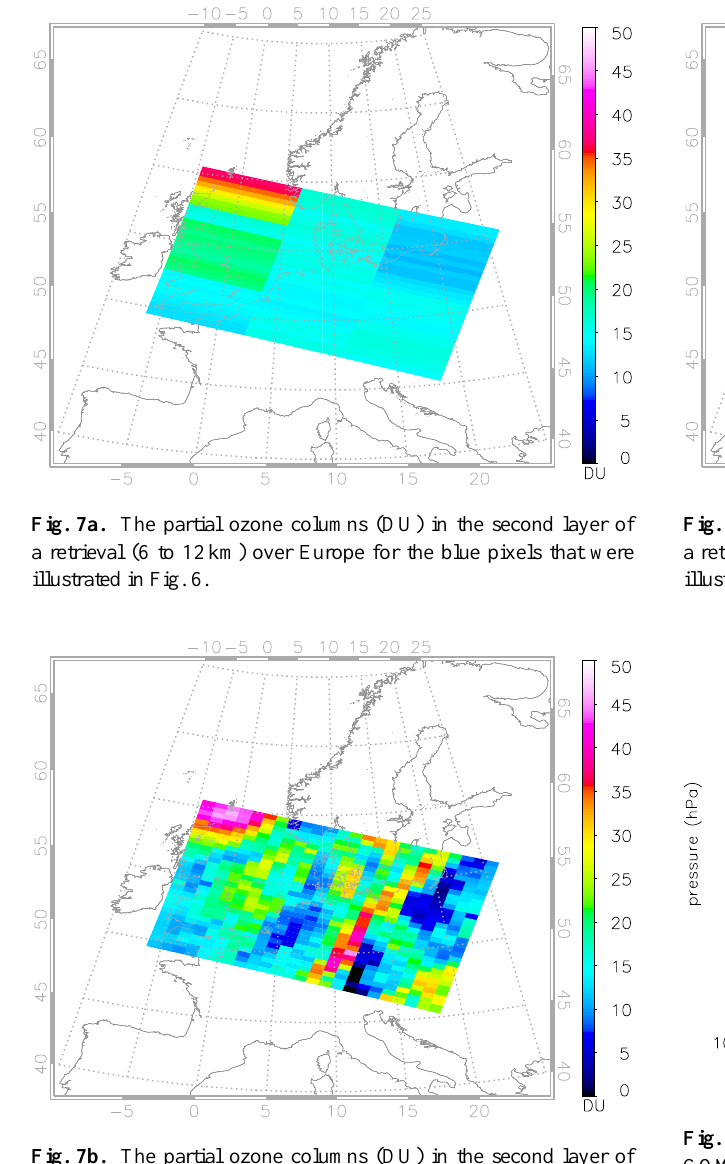
Fig. 7b. The partial ozone columns (DU) in the second layer of a retrieval (6 to 12km) over Europe for the yellow pixels that were illustrated in Fig. 6.